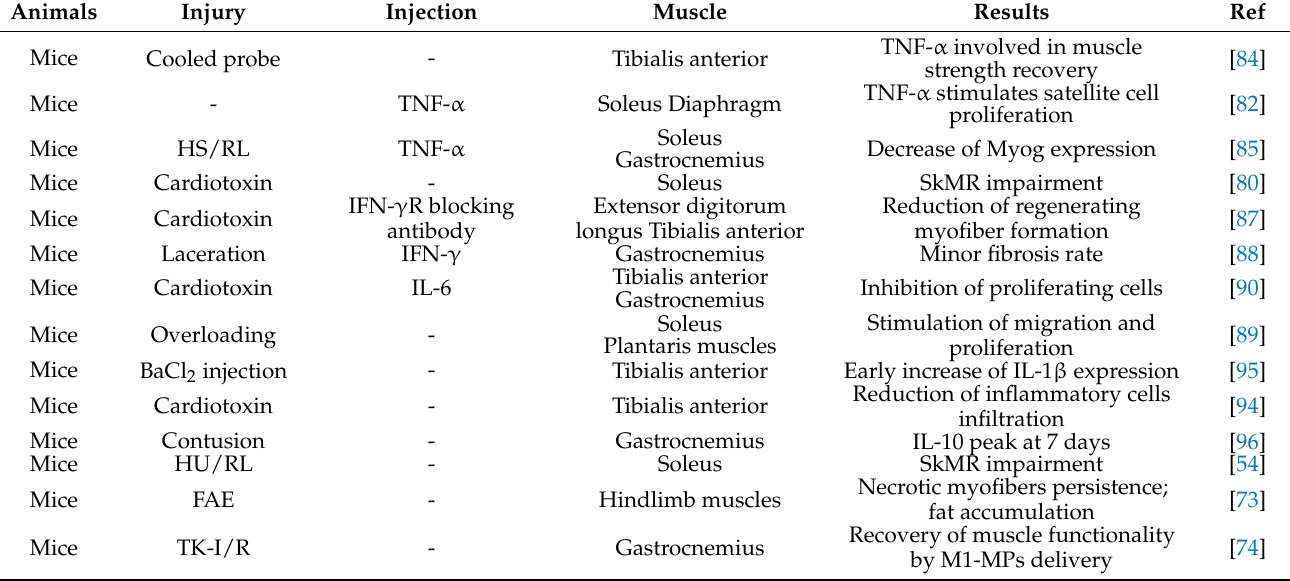
Table 5. Cytokines and skeletal muscle regeneration. In vivo